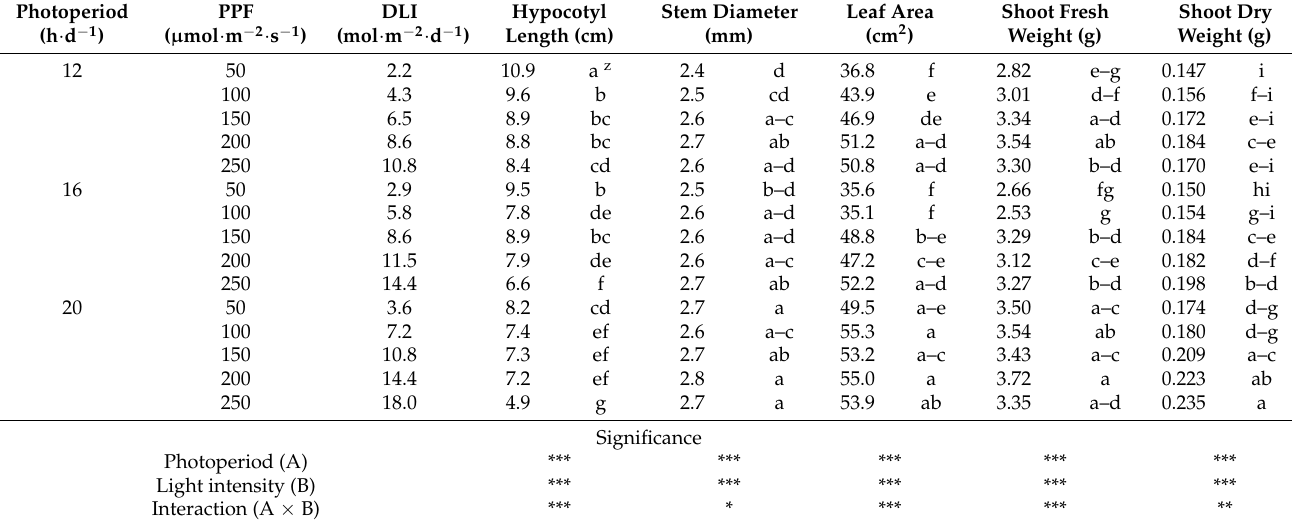
Table 4. Growth of cucumber rootstocks as affected by the different photoperiod and light intensity at 6 days after cultivation in a